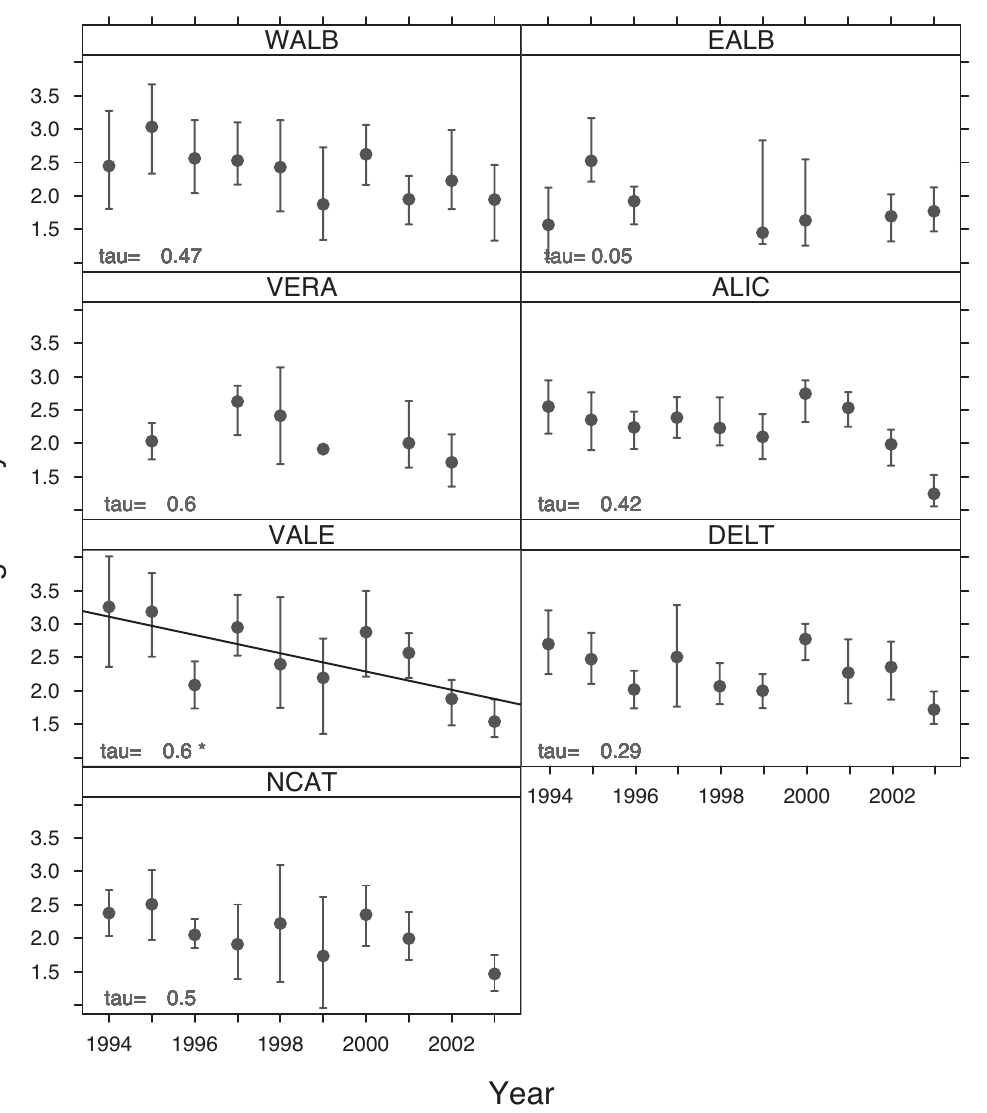
F IG . 11. – Annual variation of Liocarcinus depurator median density (log Iberian Peninsula (only hauls containing crabs were used). The value of Kendal’s T is indicated in the bottom left corner of each figure, followed by an * when significant. Lines fitted to significant relationships by least squares regression are merely indicative of the